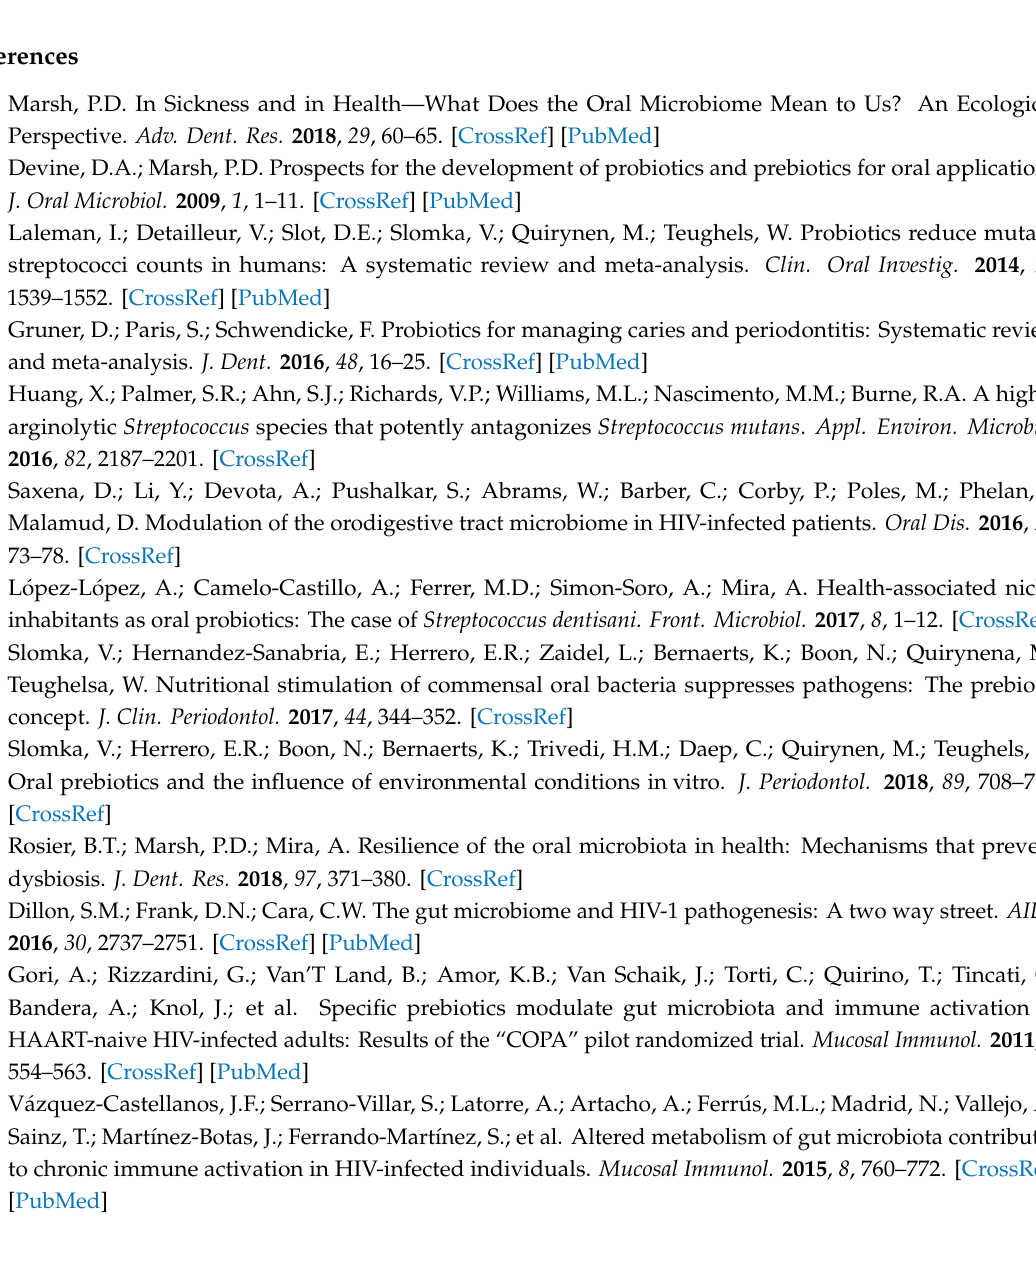
prebiotic intervention; Table S3: Sample size determination (n2) for groups before prebiotic intervention; Table S4: Sample size determination (n1) for groups after prebiotic intervention; Table S5. Sample size determination (n2) for groups after prebiotic